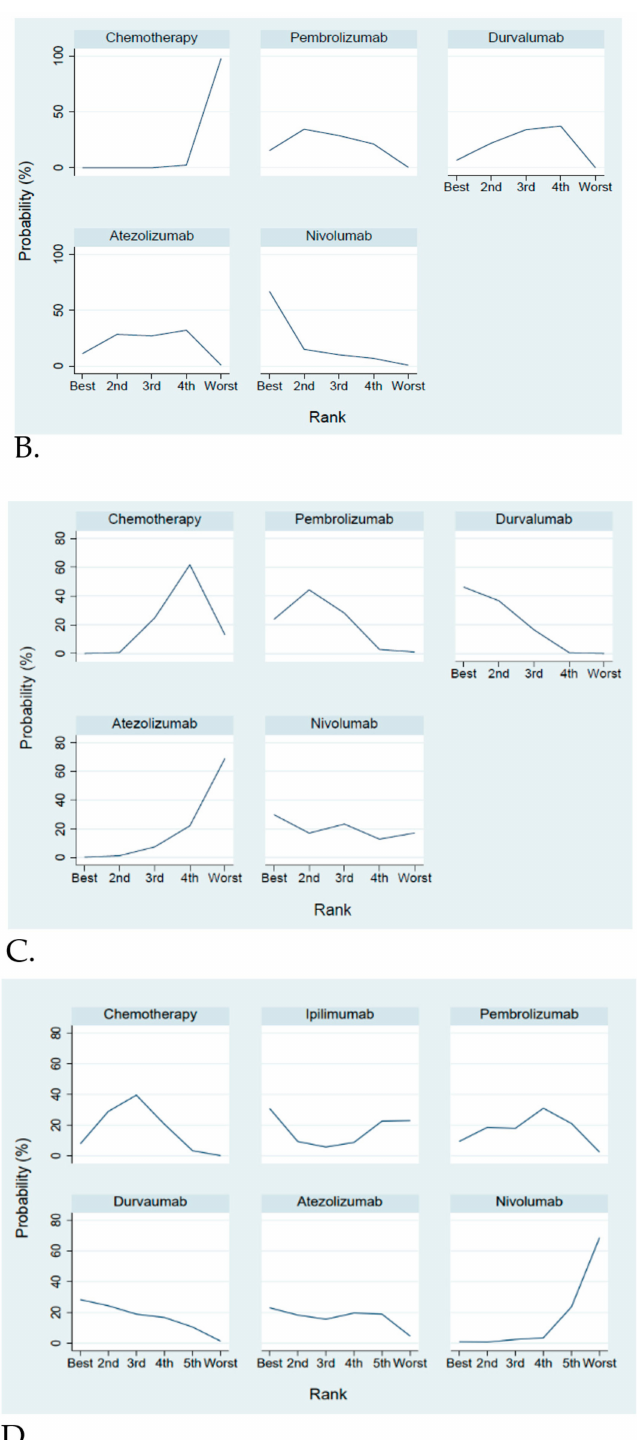
Figure 5. Probability to be the best treatment for di ff erent treatments. ( A ) Overall survival; ( B ) Progression free survival; ( C ) Objective response rate; ( D ) Grade 3–4 adverse